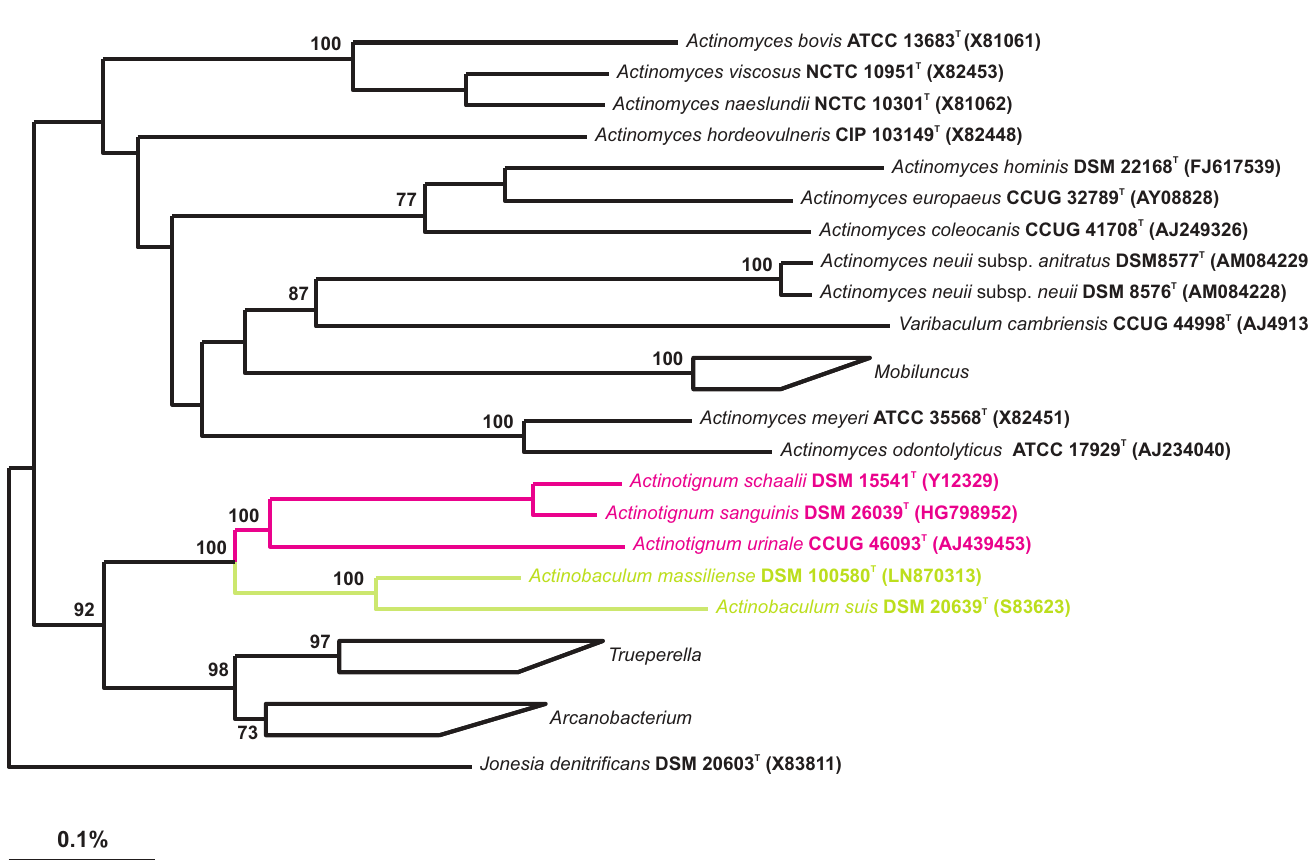
Fig 2. Neighbour-joining phylogenetic tree based on 16S rRNA gene sequences. The tree showingthe phylogeneticposition of A . schaalii DSM 15441 T , the type strains of other species of the genus Actinotignum and other related members of the generaof the family Actinomycetaceae . Jonesia denitrificans was used as outgroup. Bootstrap values ( > 70%),expressedas a percentage of 1000 replication,are indicatedat the nodes. Bar, 0.1% substitution per nucleotideposition.